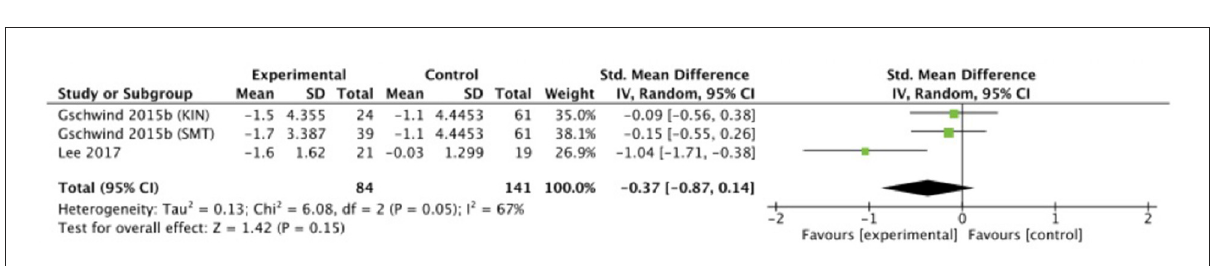
FIGURE8 Random effects meta-analysis forest plot for effectiveness of intervention on measures of STS strength outcomes.